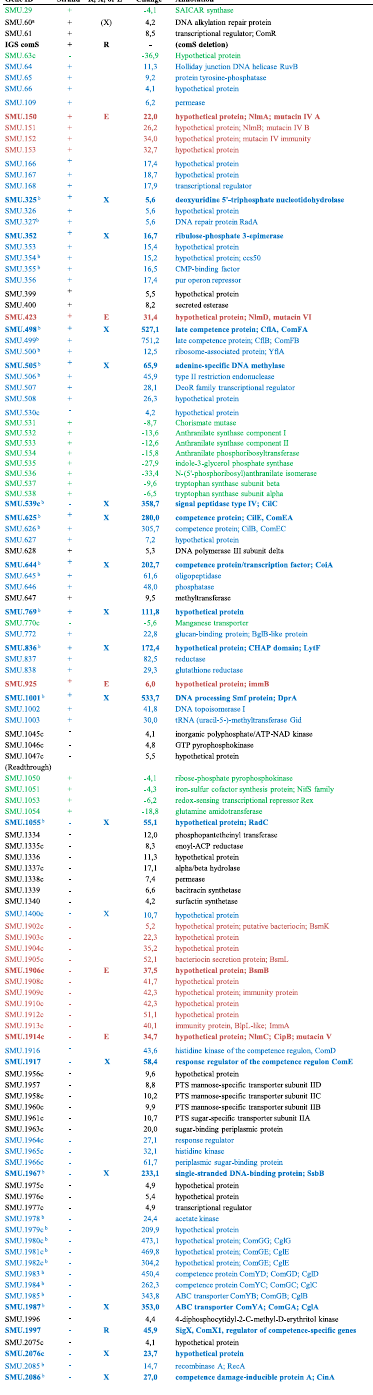
Figure 2. Genes differentially regulated in response to XIP in the S. mutans comS deletion mutant ( > 4 fold; p < 0.05; > 8000 mean reads). Genes belonging to the same transcript are grouped together. Induced genes by XIP that are specific to the early (red) and late (blue) responses to CSP are indicated by the corresponding colors 2 . Downregulated genes (green). a SMU.60 was up-regulated only in its 3 ′ -terminal region preceding comR . b Pan-streptococcal genes belonging to the SigX regulon. c First genes in the transcripts regulated by ComR (R), SigX (X), and ComE (E). d Mean fold change in transcript expression from 3 independent biological experiments comparing 120 min XIP treated to untreated parallel cultures. e Plus and minus strand for the ORF are presented, since some of the annotated genes in UA159 (accession AE014133) in the complementary strand (- strand) do not have the “c” designation after the gene